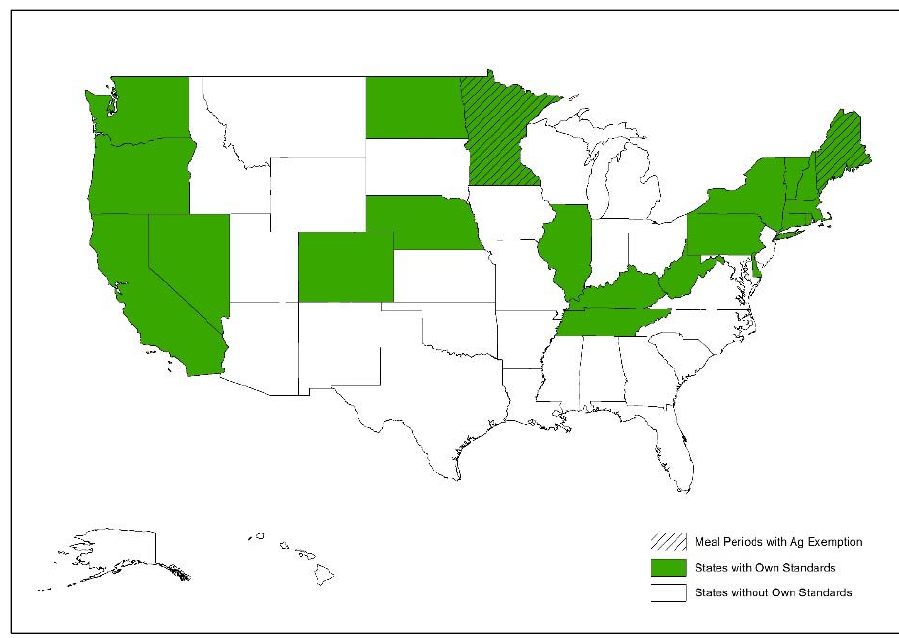
Figure 3. Rest Period Agricultural Exceptions by State, U.S.